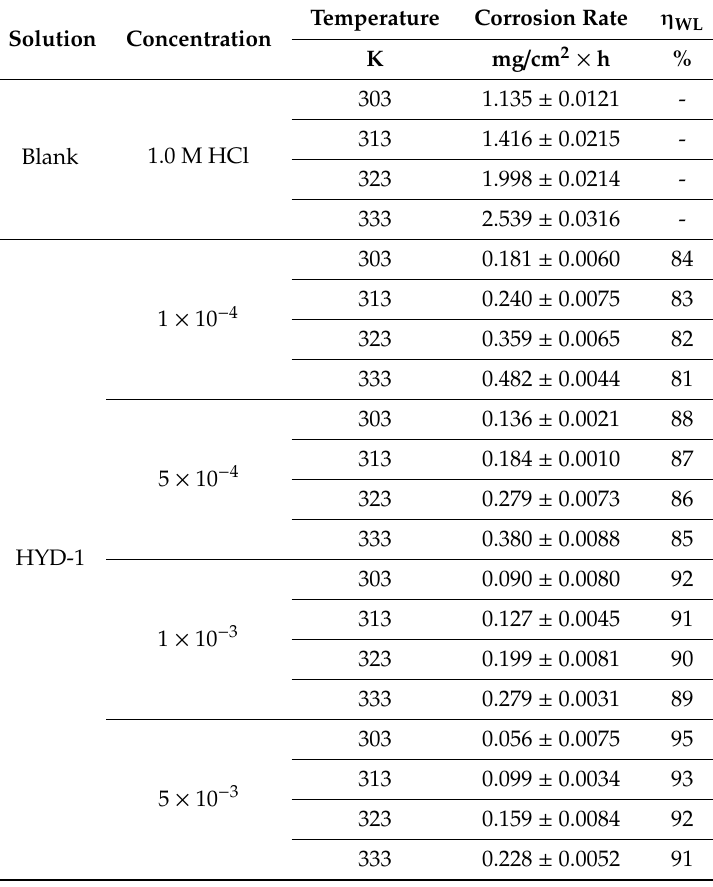
Table 1. Influence of temperature toward the corrosion rate ( ± SD) and inhibition e ffi ciency for mild steel in 1.0 M HCl with and without the HYD-1 compound.